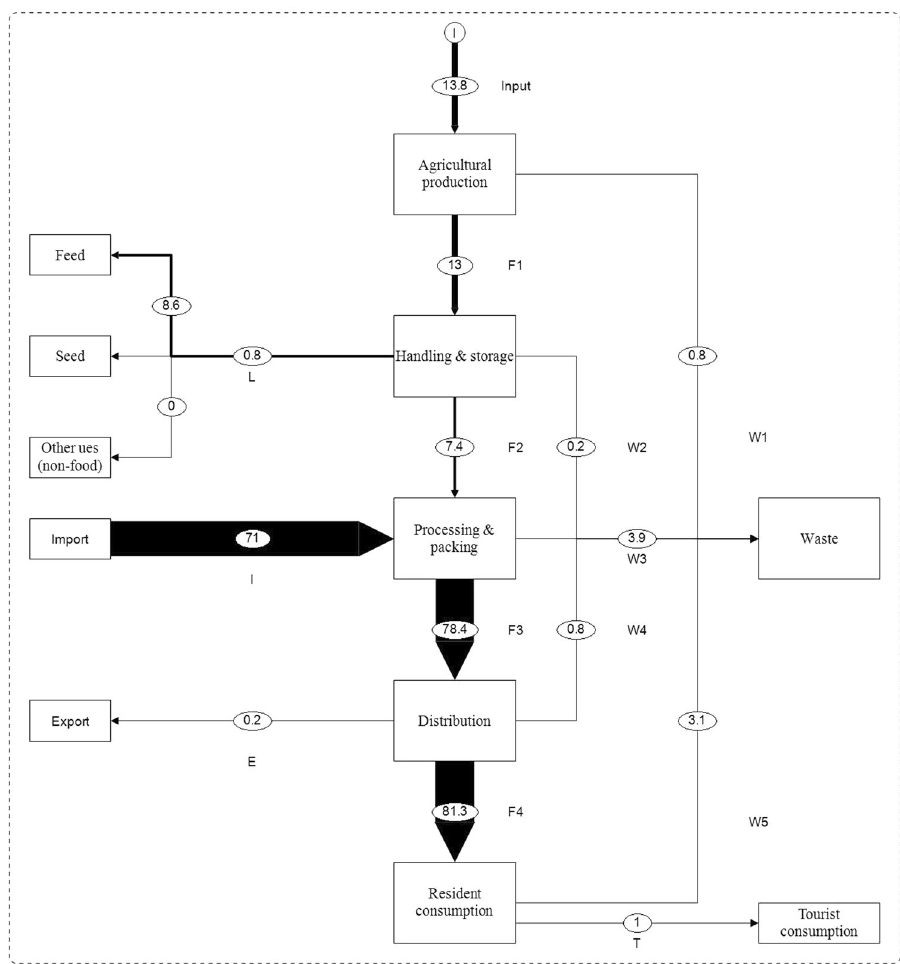
Fig. 4 Material fl ow diagram for reducing waste at each stage of the soybean food supply chain. The fl ow of soybean through the food supply chain after a 5% waste reduction in each of the fi ve stages. Values in Mt. Data are annual averages for the period 2010 –